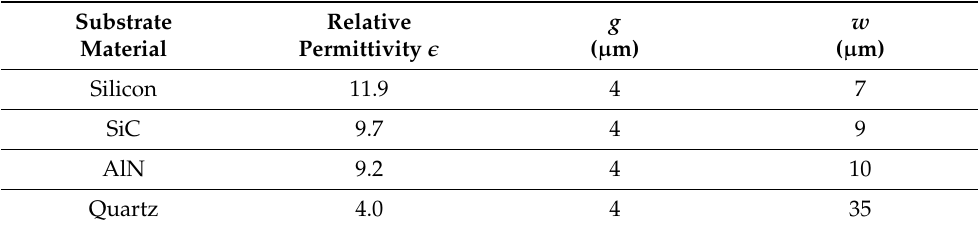
Figure 4. The cross-section view of a CPW. In this work, both high resistivity silicon and fused quartz substrate have thickness h of 500 µ m. The CPW is evaporated gold with a thickness t of 400 nm. The signal line width w and signal-ground gap g are impacted by the substrate’s relative permittivity. Table 1. The cross-section dimensions of a 50 Ω CPW on different